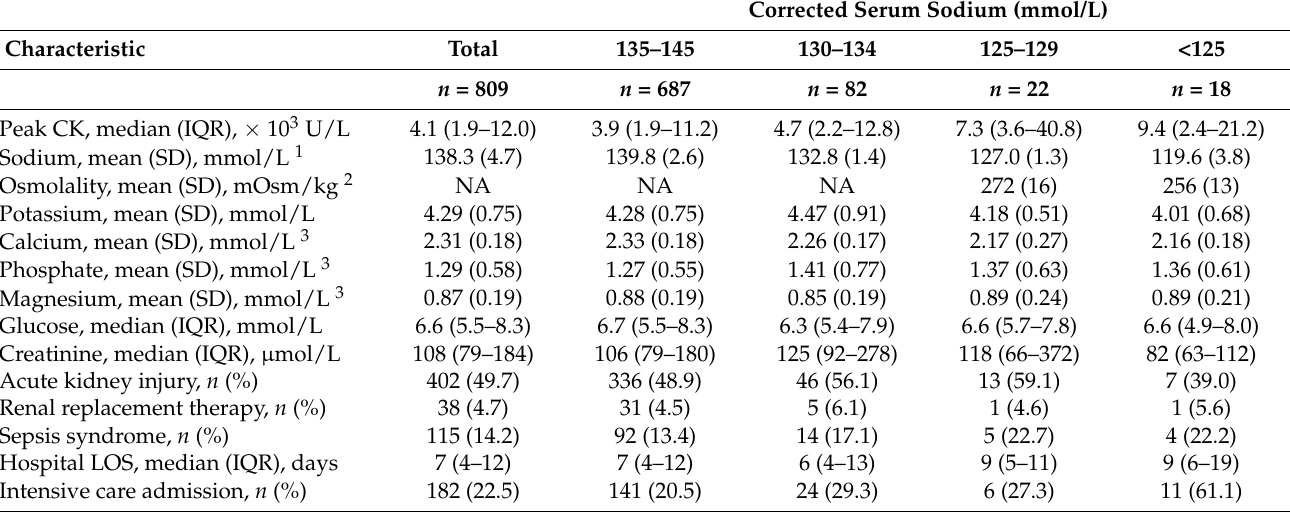
Table 2. Biochemistry at hospital presentation and relevant clinical data grouped by serum